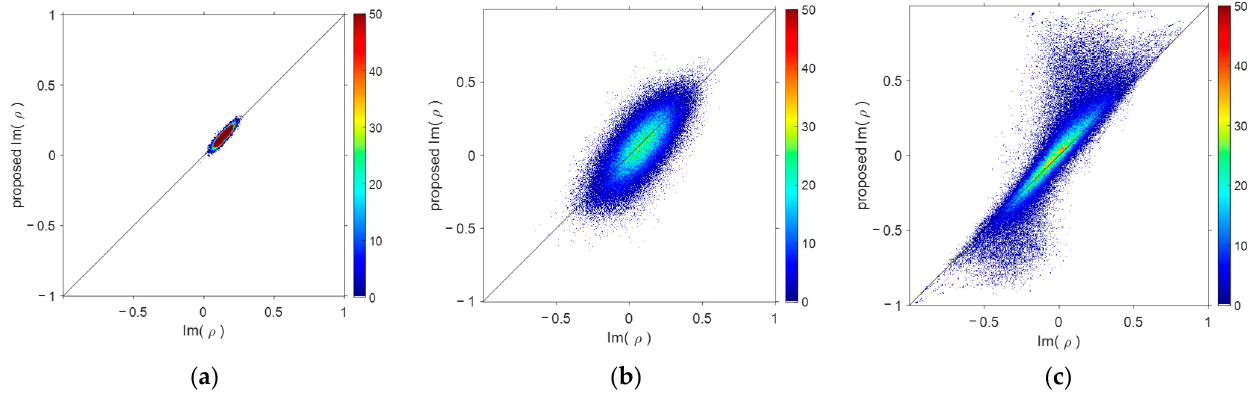
Figure 3. The comparison between the imaginary part of the original ρ and proposed ρ value. ( a ) Ocean area. ( b ) Mountain area. ( c ) Urban area. Table 1. The mean error modulus between proposed ρ value in Equation (20) and the real ρ value in Equation (11). Mean